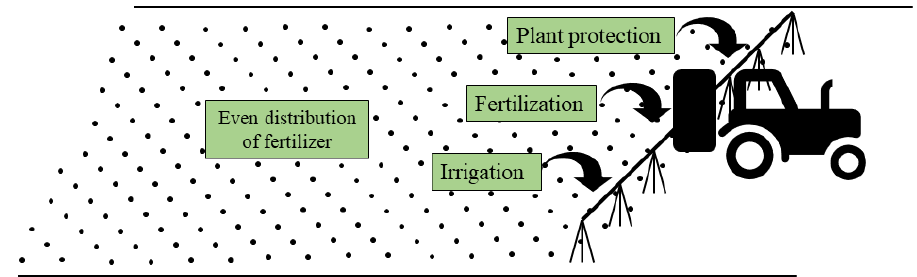
Figure 2. Application of suspension fertilizers. Suspension fertilizers can be applied to the field using typical agricultural equipment, in conjunction with irrigation and plant protection treatment. The effect of such fertilization is an even distribution of the fertilizing ingredients over the surface of the field.